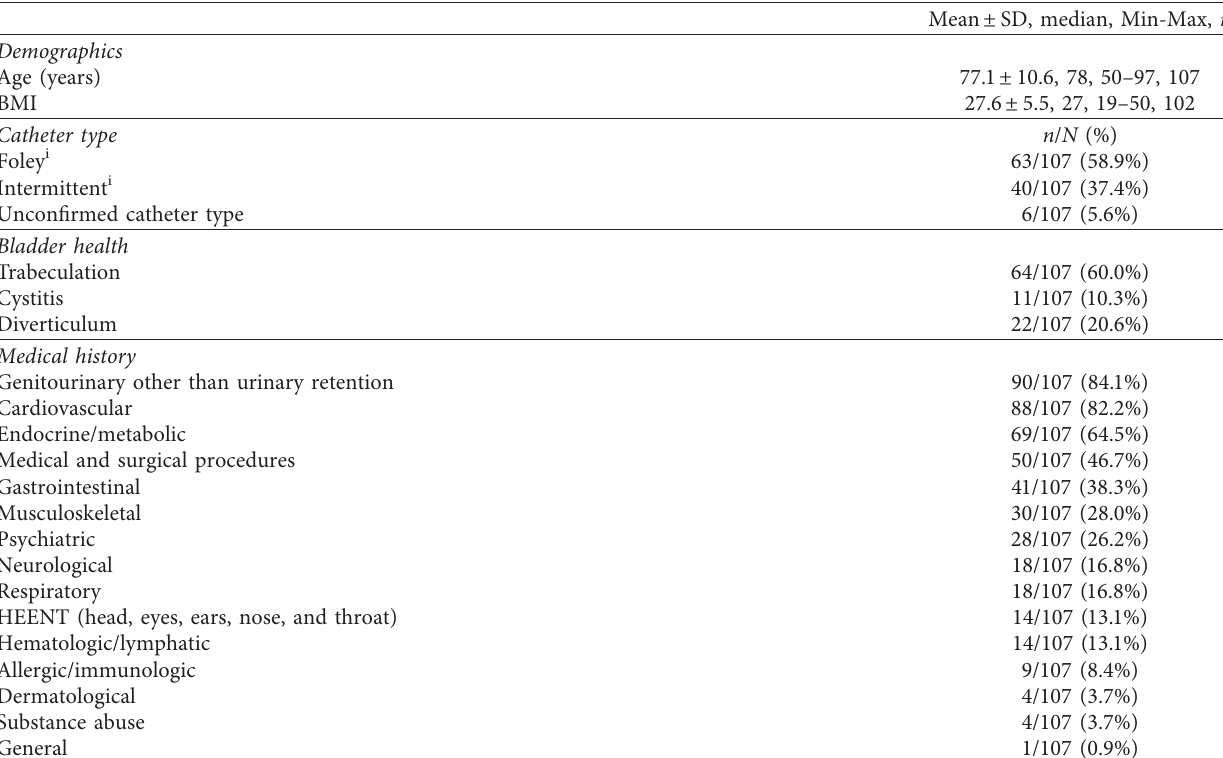
Table 2: Characteristics at